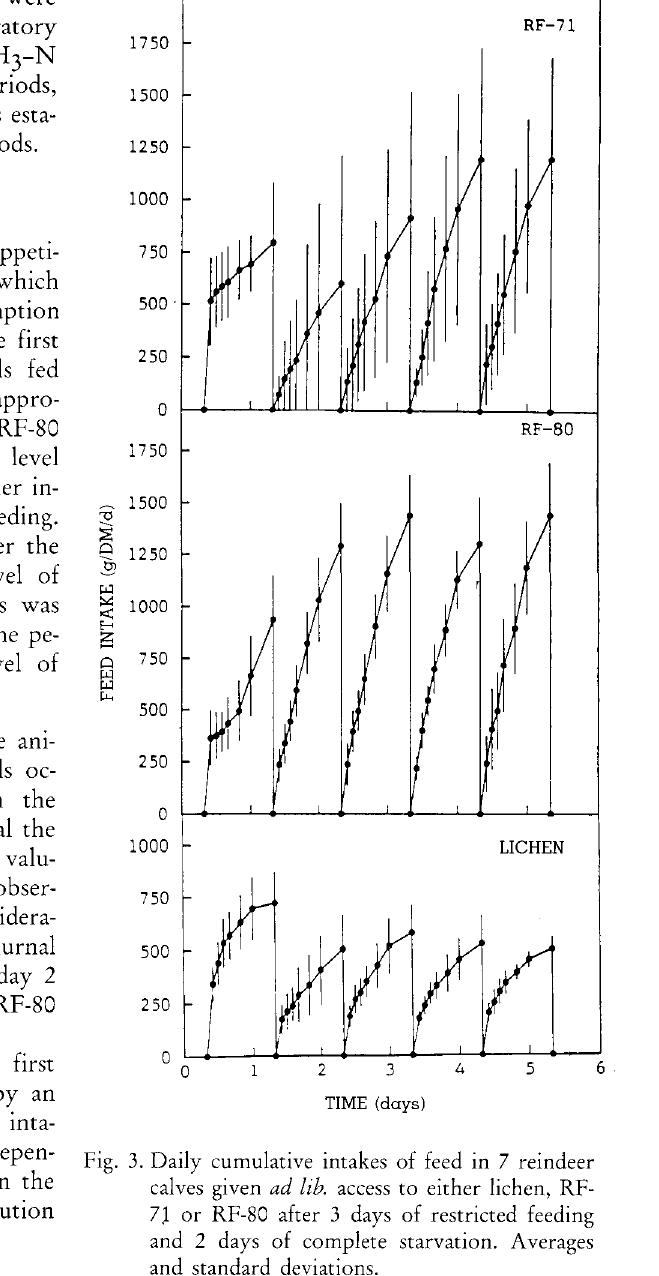
Fig. 3. Daily cumulative intakes of feed in 7 reindeer calves given ad lib. access to either lichen, RF- 71 or RF-80 after 3 days of restricted feeding and 2 days of complete starvation.